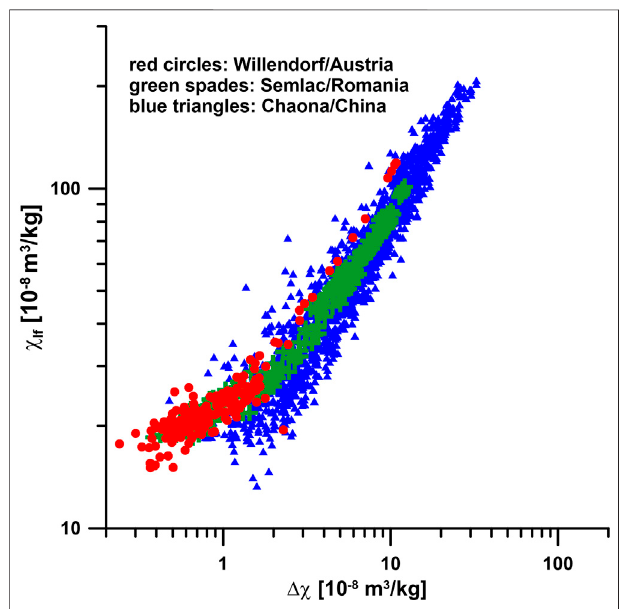
FIGURE 4 | Magnetic enhancement at Willendorf, compared with Semlac in the Middle Danube Basin (Zeeden et al., 2016) and Chinese loess from Chaona (Song et al., 2007). Note that this is a double logarithmic plot.